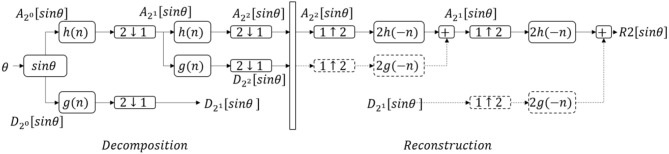
The denoising process with discrete wavelet transform. θ, tilt angle; A2j[sinθ], low frequency components; D2j[sinθ], high frequency components with j, number of iteration; h(n), low pass filter; g(n), high pass filter; 2↓1, downsample by half; 1↓2, upsample by double; Rj[sinθ], denoised signal after j iterations. Dash lines mean suppressing the components to zero. This figure shows an example of the denoising process with two iterations.